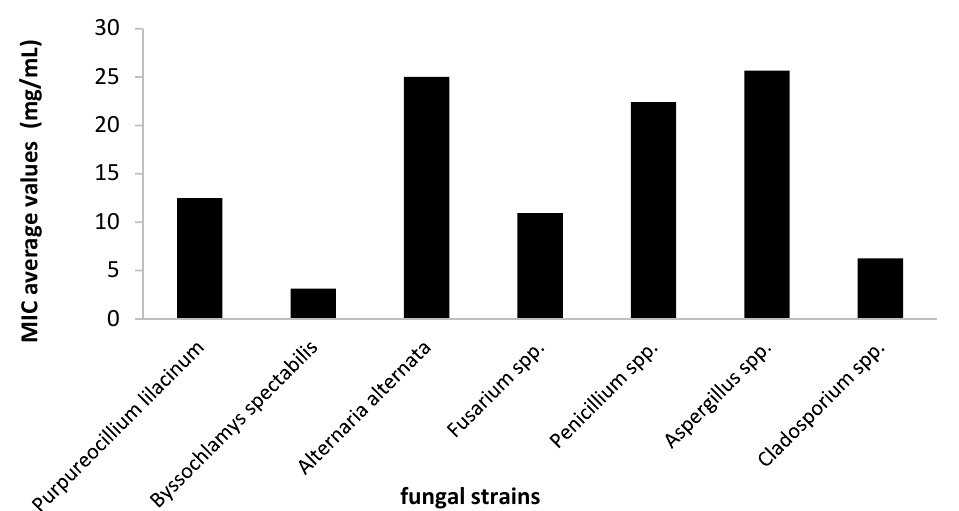
Figure 6. Average values of minimal inhibitory concentration (MIC) of A. sativum extract obtained on the tested fungi.